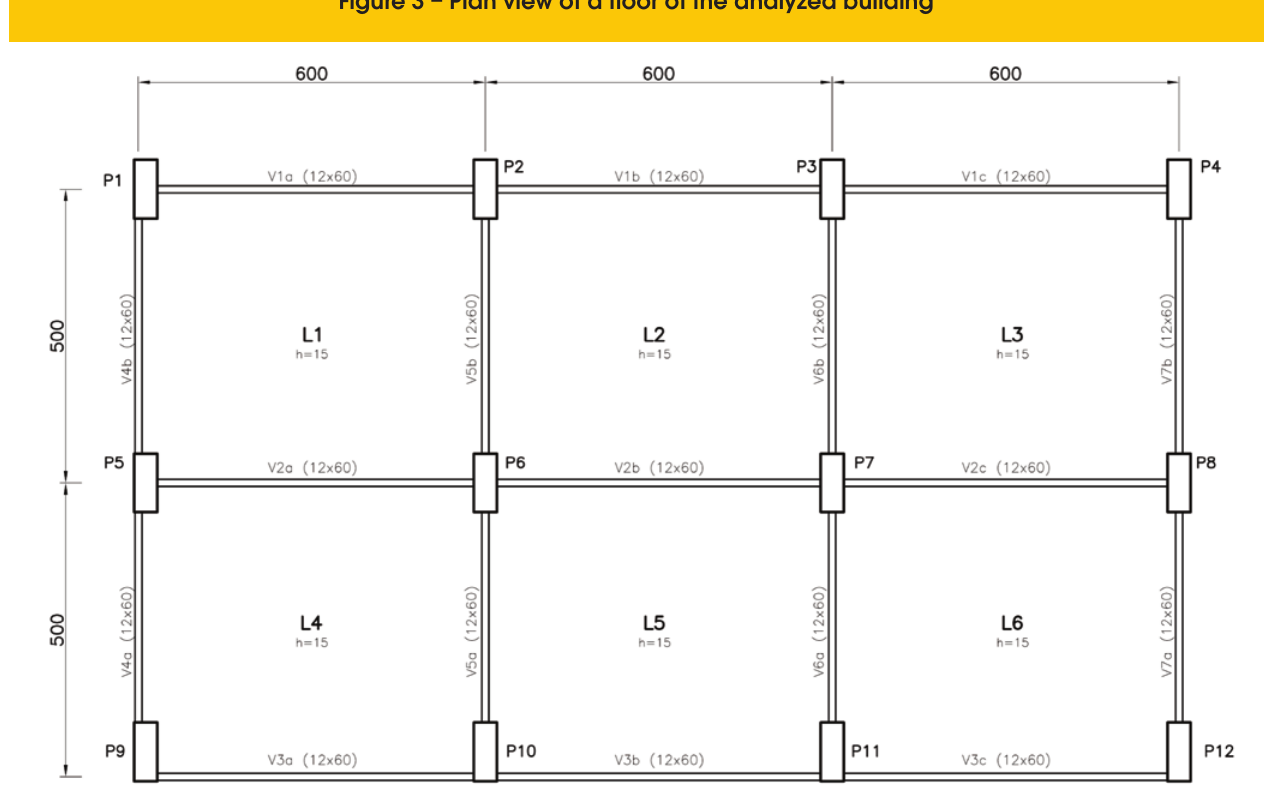
Figure 3 – Plan view of a floor of the analyzed